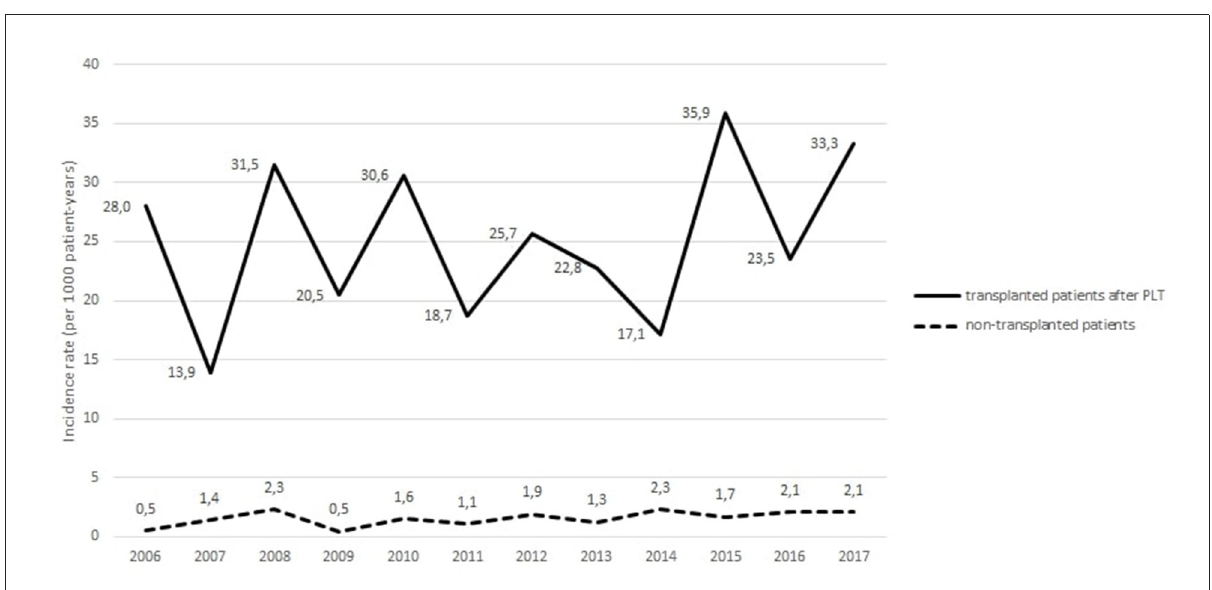
and expected cancers with corresponding SIR and 95%CI values among non-transplanted patients for the period from 2006 to 2017. For the 54,425 person-years of observation during the period from 2006 to 2017, 86 invasive cancers were reported in non-transplanted CF patients compared to 33.5 expected cancers in the general population (SIR = 2.57, 95%CI 2.05 to 3.17) (Table 3). There was a significantly higher number of